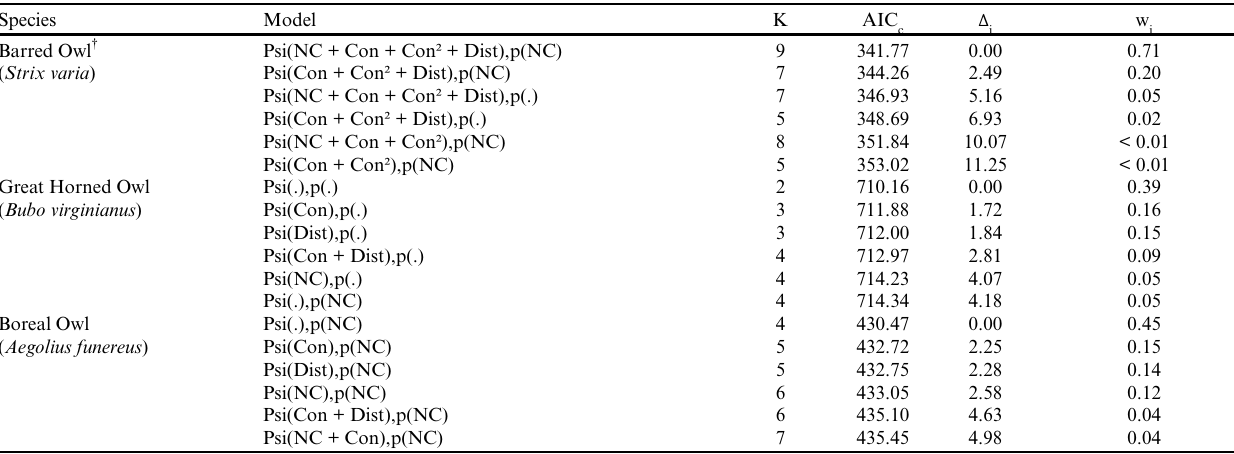
Table 2 . Comparison of occupancy models for owls at the site level (n = 72 sites). Occupancy (psi) and detection probability (p) are modeled with noise category (NC) (chronic, intermittent, or no noise) as a factor. Percent coniferous forest (Con) and proportion of the area disturbed by humans (Dist) were included as factors to account for differences in forest composition and disturbance. The number of parameters is represented by K. Models were evaluated based on differences between AIC scores ( Δ ) and AIC weights c i c (w ). Only the first six models with the lowest Δ are reported here, Δ is the difference between the observed model (i) and the best model i i i as determined by the lowest AIC c